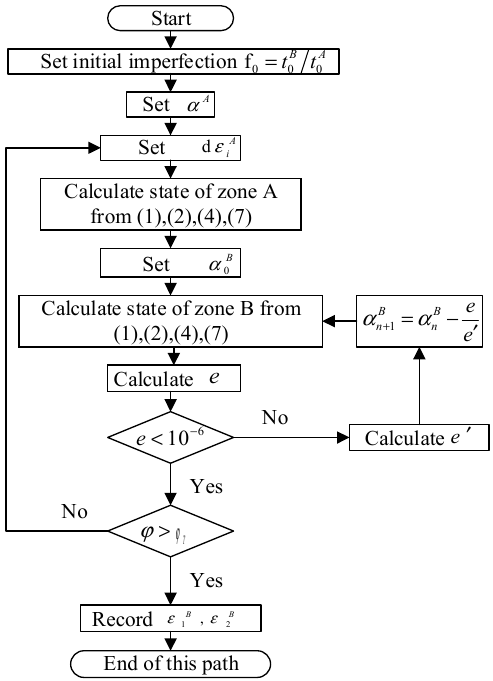
Figure 2. Flow chart of each path.